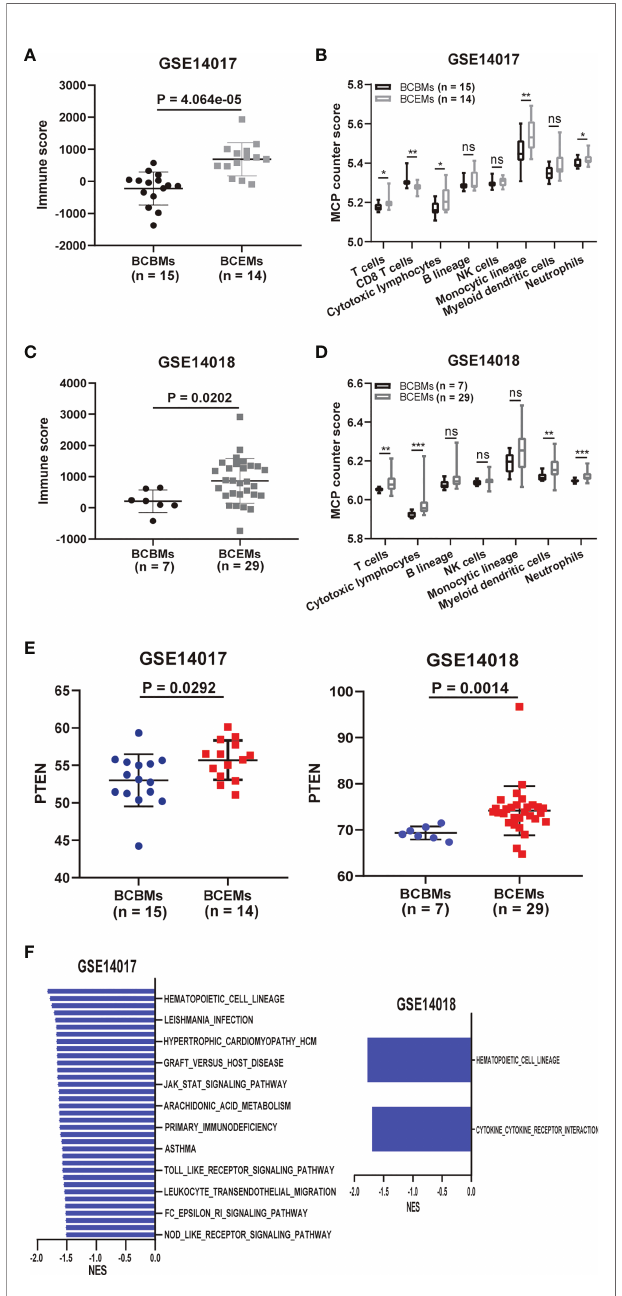
FIGURE 5 | Comparison of immune and metabolic characteristics between BCBMs and BCEMs. (A, B) ESTIMATE immune and MCP-counter analysis